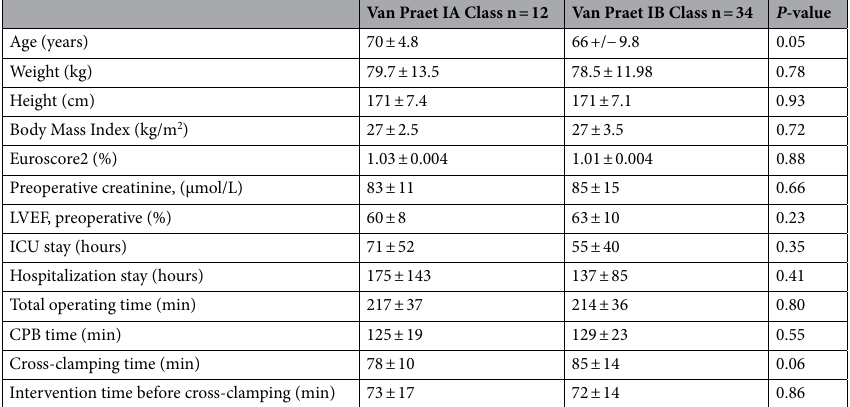
Table 2. Operating data and patient characteristics. CPB cardiopulmonary bypass, ICU intensive care unit, LVEF left ventricle ejection